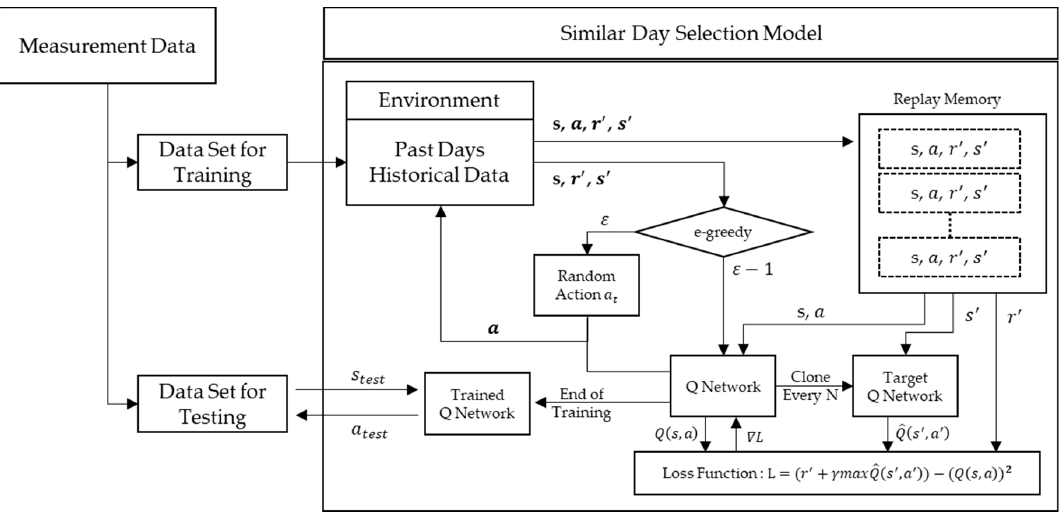
Figure 2. Model structure of the proposed similar day selection model based on reinforcement learning.